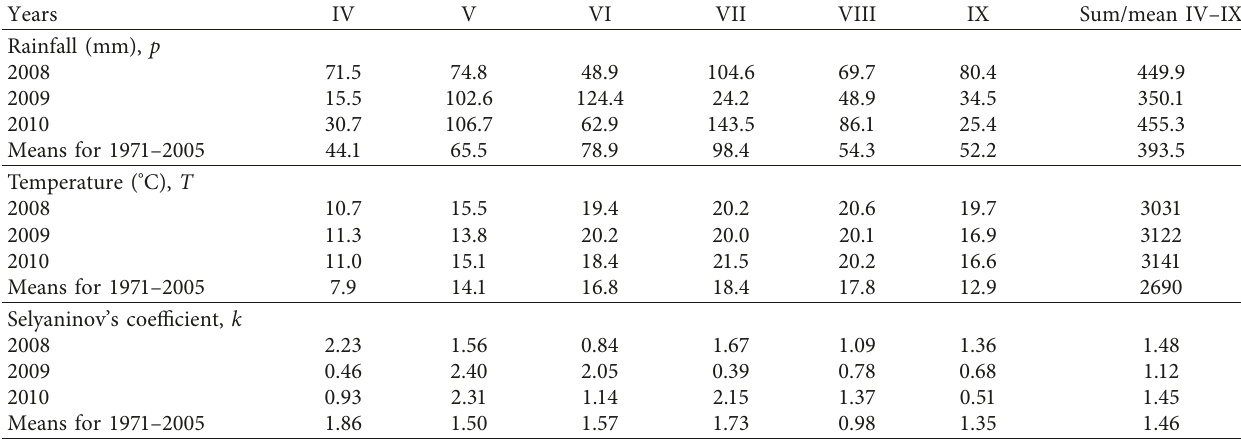
Phase of harvest Biomass for silage